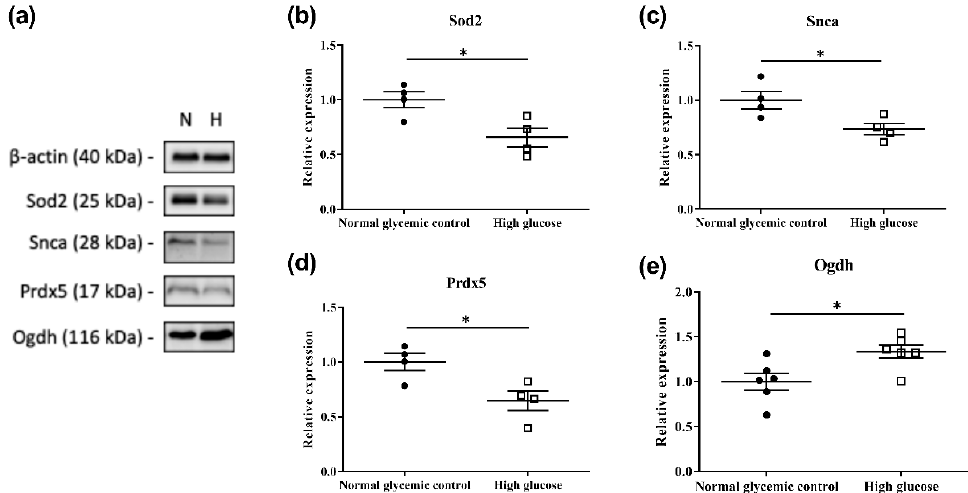
Figure 4. Validation of four differentially expressed proteins involved in mitochondrial dysfunction by Western blot analysis. ( a ) Representative Western blot (N: normal glycemic control and H: high glucose); ( b – e ) plots showing the densitometry analysis for protein levels relative to the normal glycemic control. β -actin was used as a loading control. Results illustrate the downregulation of Sod2 (~25 kDa), Snca (dimer form, ~28 kDa), and Prdx5 (~17 kDa) and the upregulation of Ogdh (~116 kDa) in 661w cells incubated in high glucose, which are consistent with our MS results. (* p < 0.05; data presented as mean ± SEM. n ≥ 4 (biological replicates) for each plot).